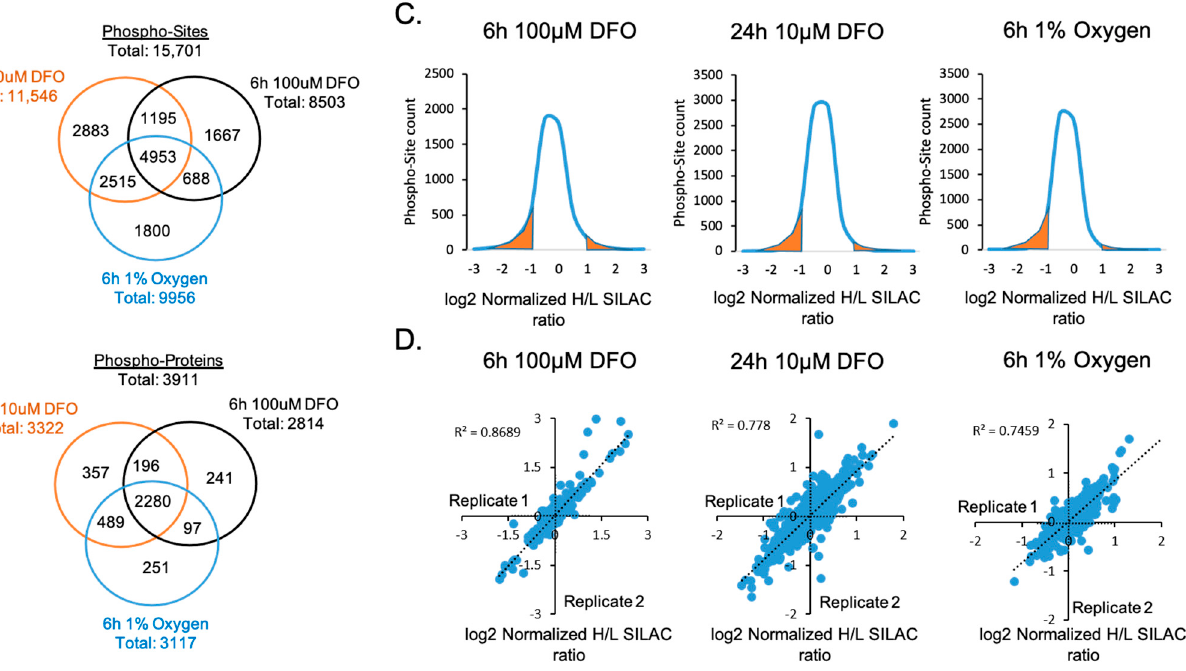
Figure 3. Quantitative analysis of phosphorylated proteins and peptides. Venn diagrams show the number of ( A ) phospho-sites and ( B ) phosphorylated proteins that were commonly or uniquely identified upon 6 h 100 µM DFO, 24 h 10 µM DFO, or 6 h 1% oxygen treatments. ( C ) Distributions of log 2 normalized phosphorylation site SILAC Heavy/Light ( H/L) ratios under each treatment. Highlighted in orange is the area under the curve representing quantifiable phospho-sites with a significant log 2 normalized H/L SILAC ratio ≤− 1 and ≥ +1. ( D ) Correlations of replicated quantification of phosphorylation proteome in each treatment.